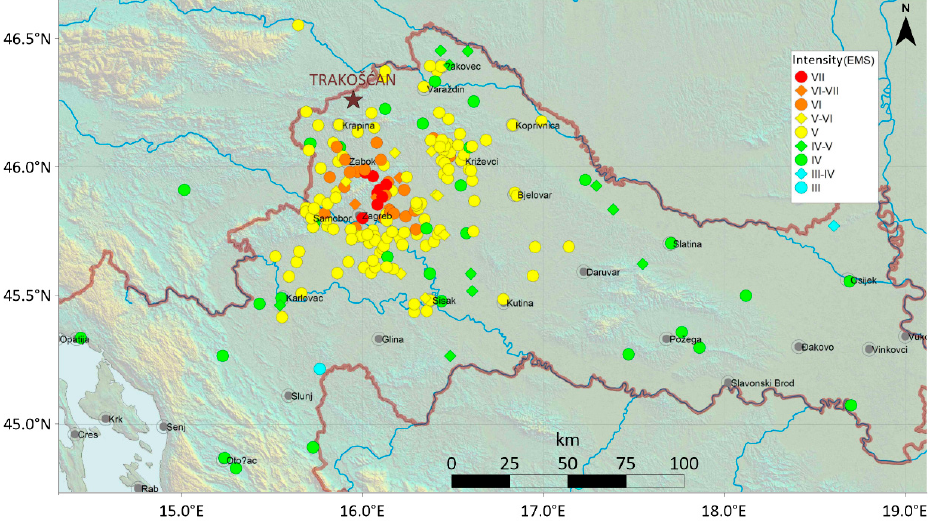
Figure 3. Adapted preliminary intensity map of Zagreb M5.5 2020 earthquake, prepared by the Seismological Survey, Department of Geophysics, Faculty of Science, Zagreb, Croatia [19]. The position of Trakoš ć an Castle is marked with a brown star.